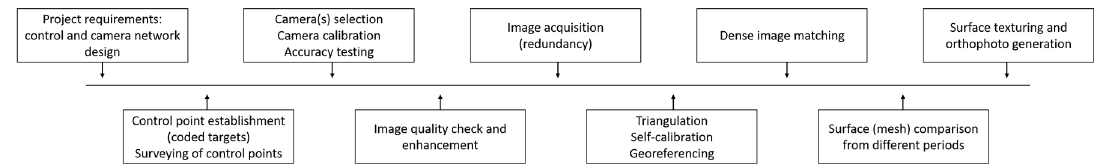
Figure 1. Steps of the implemented photogrammetric approach for coral reef temporal monitoring.